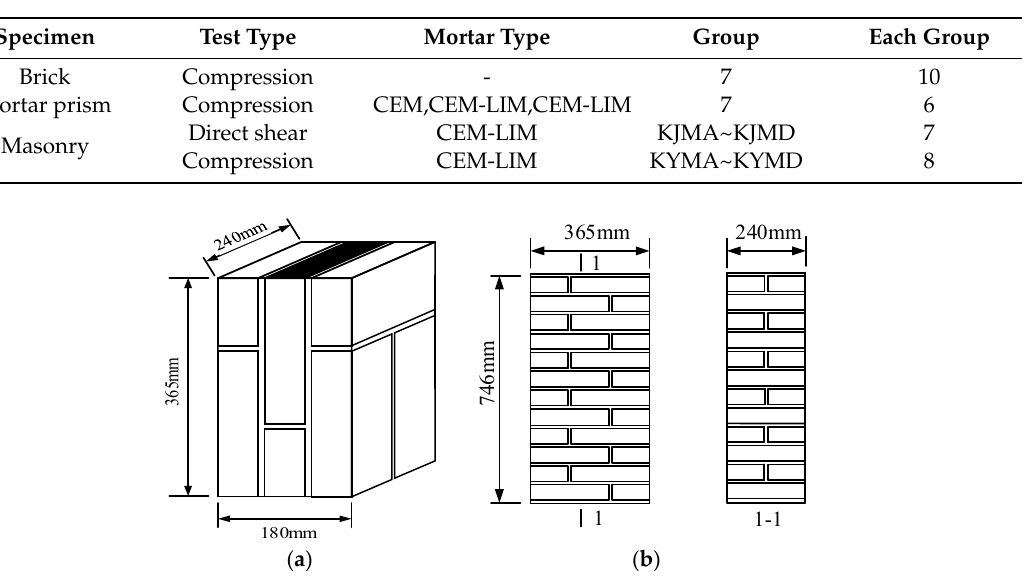
Figure 1. Layout of specimens used for ( a ) masonry direct shear and ( b ) masonry compression.